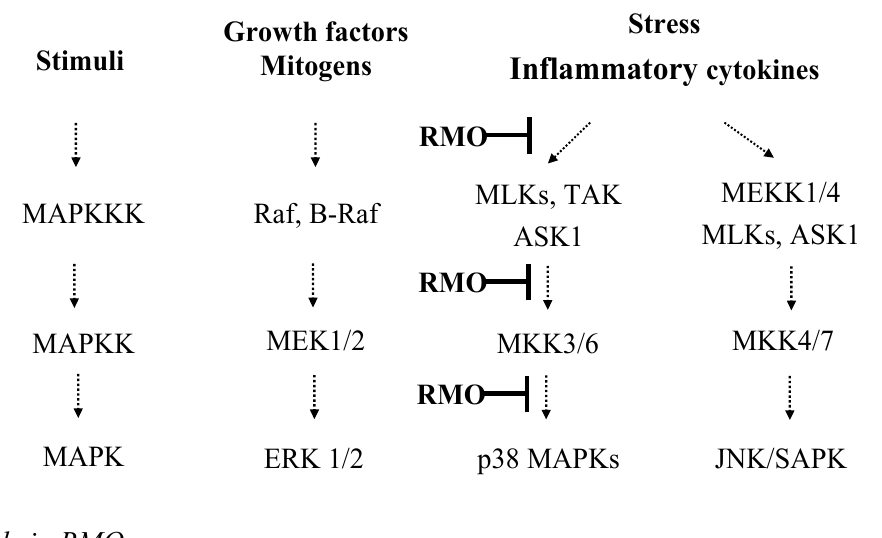
Figure 6. Schematic diagram illustrating the MAPK signaling cascades involved in RMO’s inhibition of LPS-induced inflammation in RAW 264.7 cells.